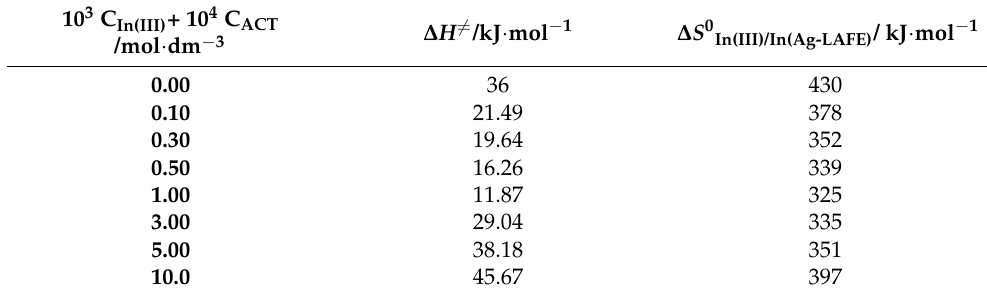
Table 4. The values of standard activation energy ( ∆ H # ) and standard reaction entropy ( ∆ S 0 ) for the In(III) ions electroreduction in the 1 mol · dm − 3 chlorates(VII) and in the presence of 1 × 10 − 3 mol · dm − 3